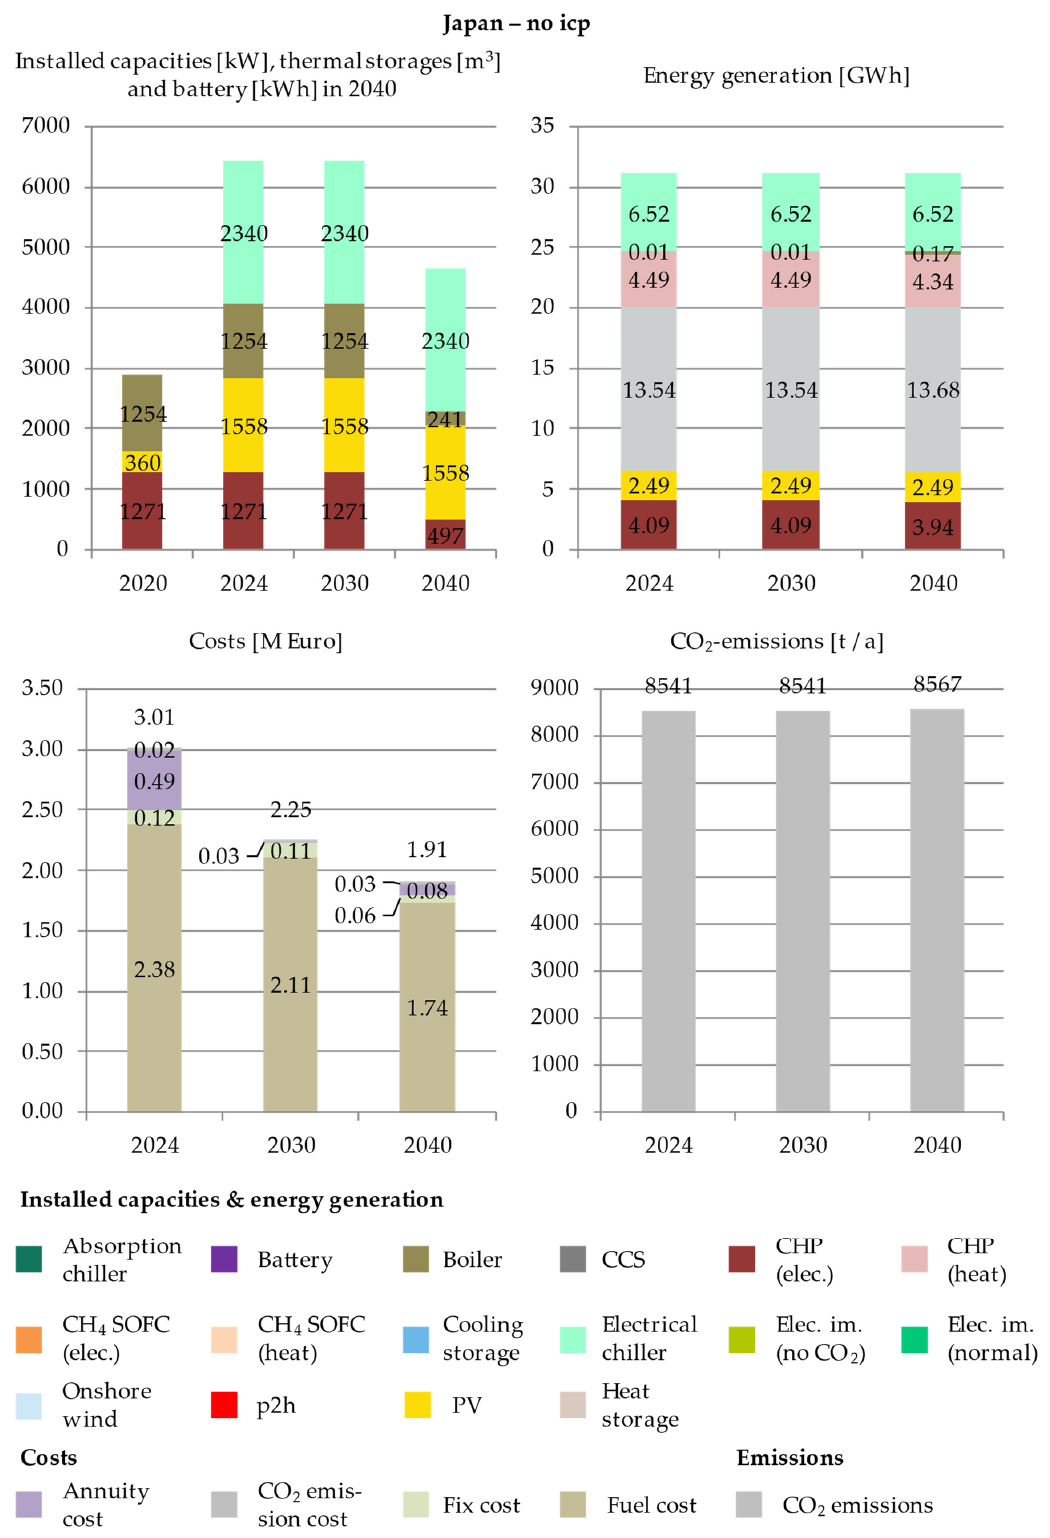
Figure A6. Detailed results for the Japanese “no ICP” scenario.